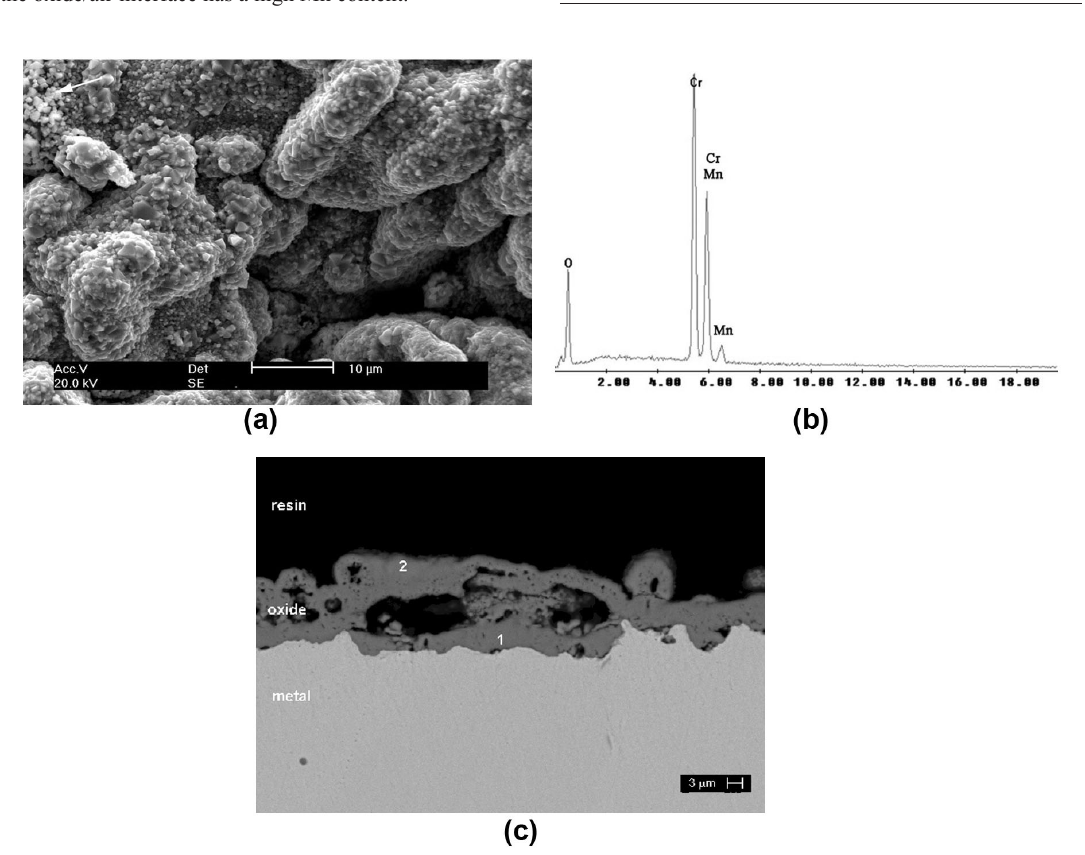
Figure 1: Scanning electron micrographs and the EDS spectrum of uncoated Fe-20Cr alloy specimen oxidized for 200h at 1000ºC. (a) The surface; (b) the EDS spectrum of the surface; (c) cross section of the specimen.